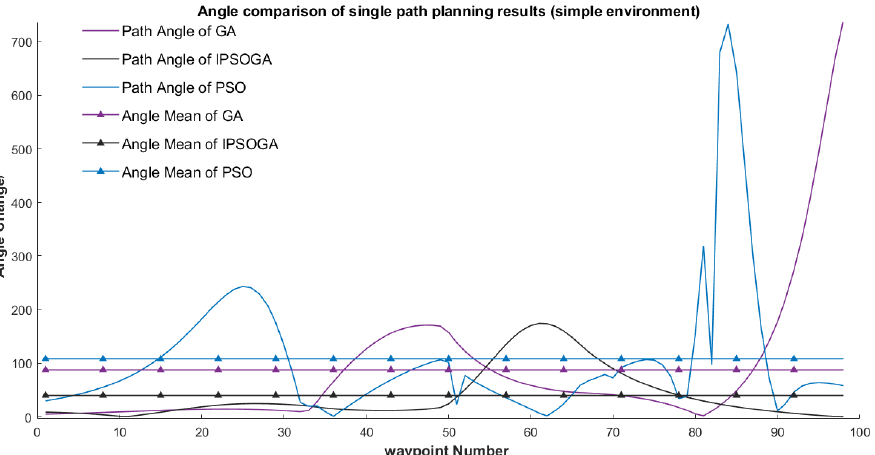
Figure 11. Comparison of path angle (simple environment).